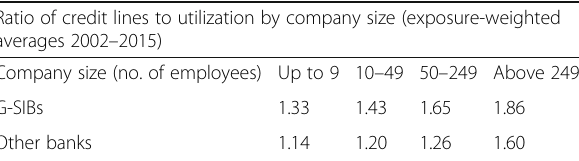
Table 3 Corporate loans G-SIBs versus other banks Ratio of credit lines to utilization by company size (exposure-weighted averages 2002 –